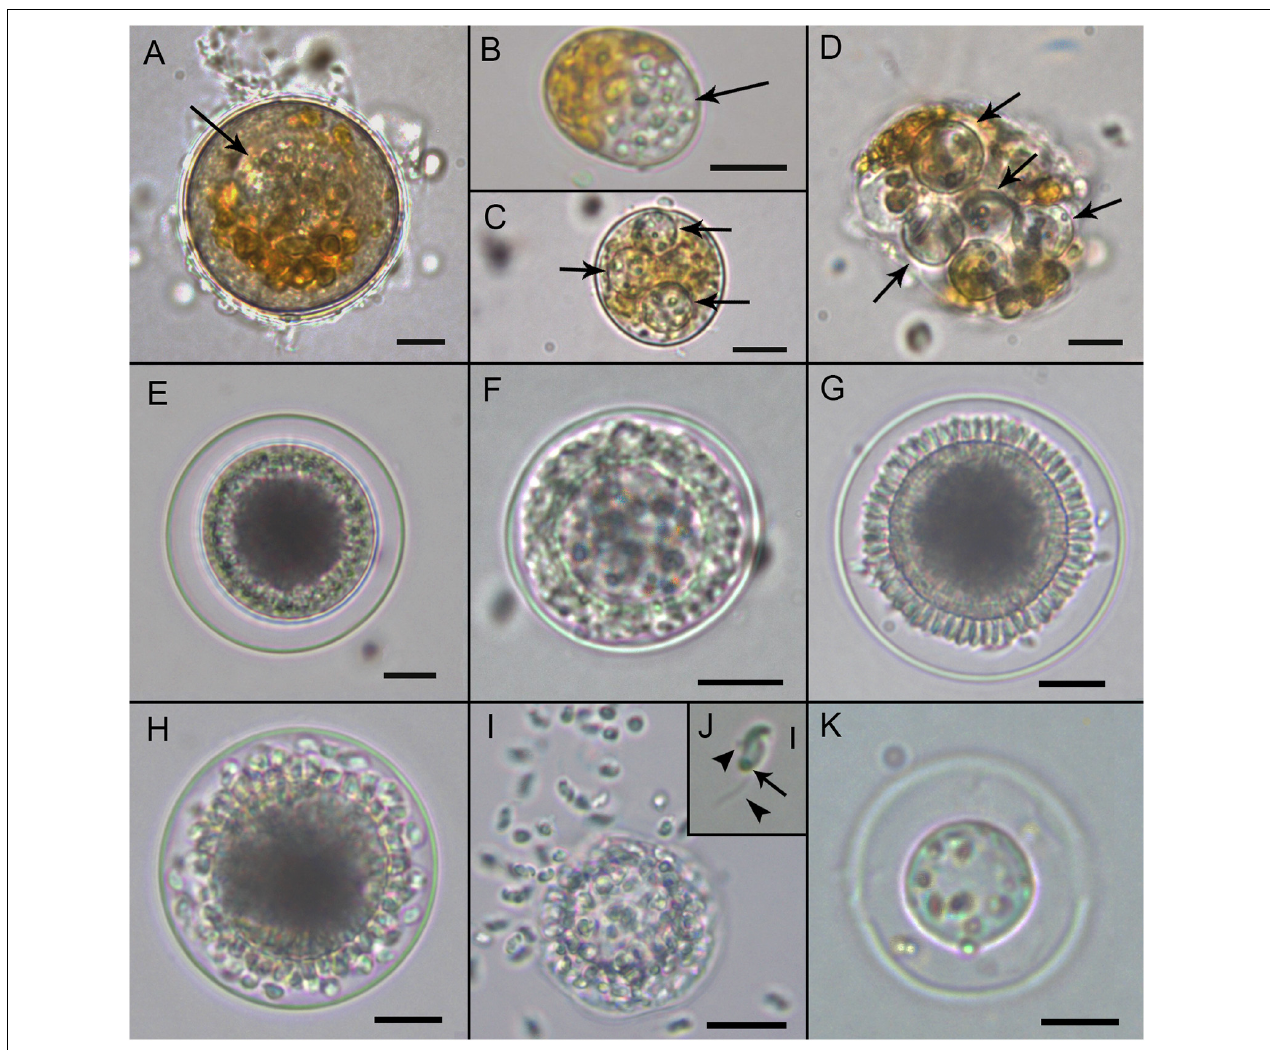
FIGURE 2 | Light microscopy micrographs showing the life-cycle stages of Maranthos nigrum (strain Sant Pol 2018) during an infection of Alexandrium taylorii. (A) Early infection on an A. taylorii cell. (B) Trophont (arrow) developing inside an elongated/ecdysed host cell. (C) Three hyaline trophonts (arrows) containing many refractive small bodies. (D) Multiple late trophonts (arrows) on a single host cell, showing cytoplasm accumulation in the periphery. (E) An early sporont begins to accumulate organelles in the cytoplasm. (F) Sporont showing the early formation of zoospores in the periphery of the inner membrane. (G) Late sporont showing the budding process of zoospore formation arranged around a central blackish body. (H) Mature sporangium with zoospores detaching from the central body. (I) Zoospores emerging from the sporangium after the rupture of the external wall. (J) The typical sigmoid shape of the zoospores. Arrowheads indicate anterior and posterior flagellum, and the arrow indicates the refractive body. (K) Empty sporangium with the residual body. All scale bars = 10 µ m, except (J) = 2 µ